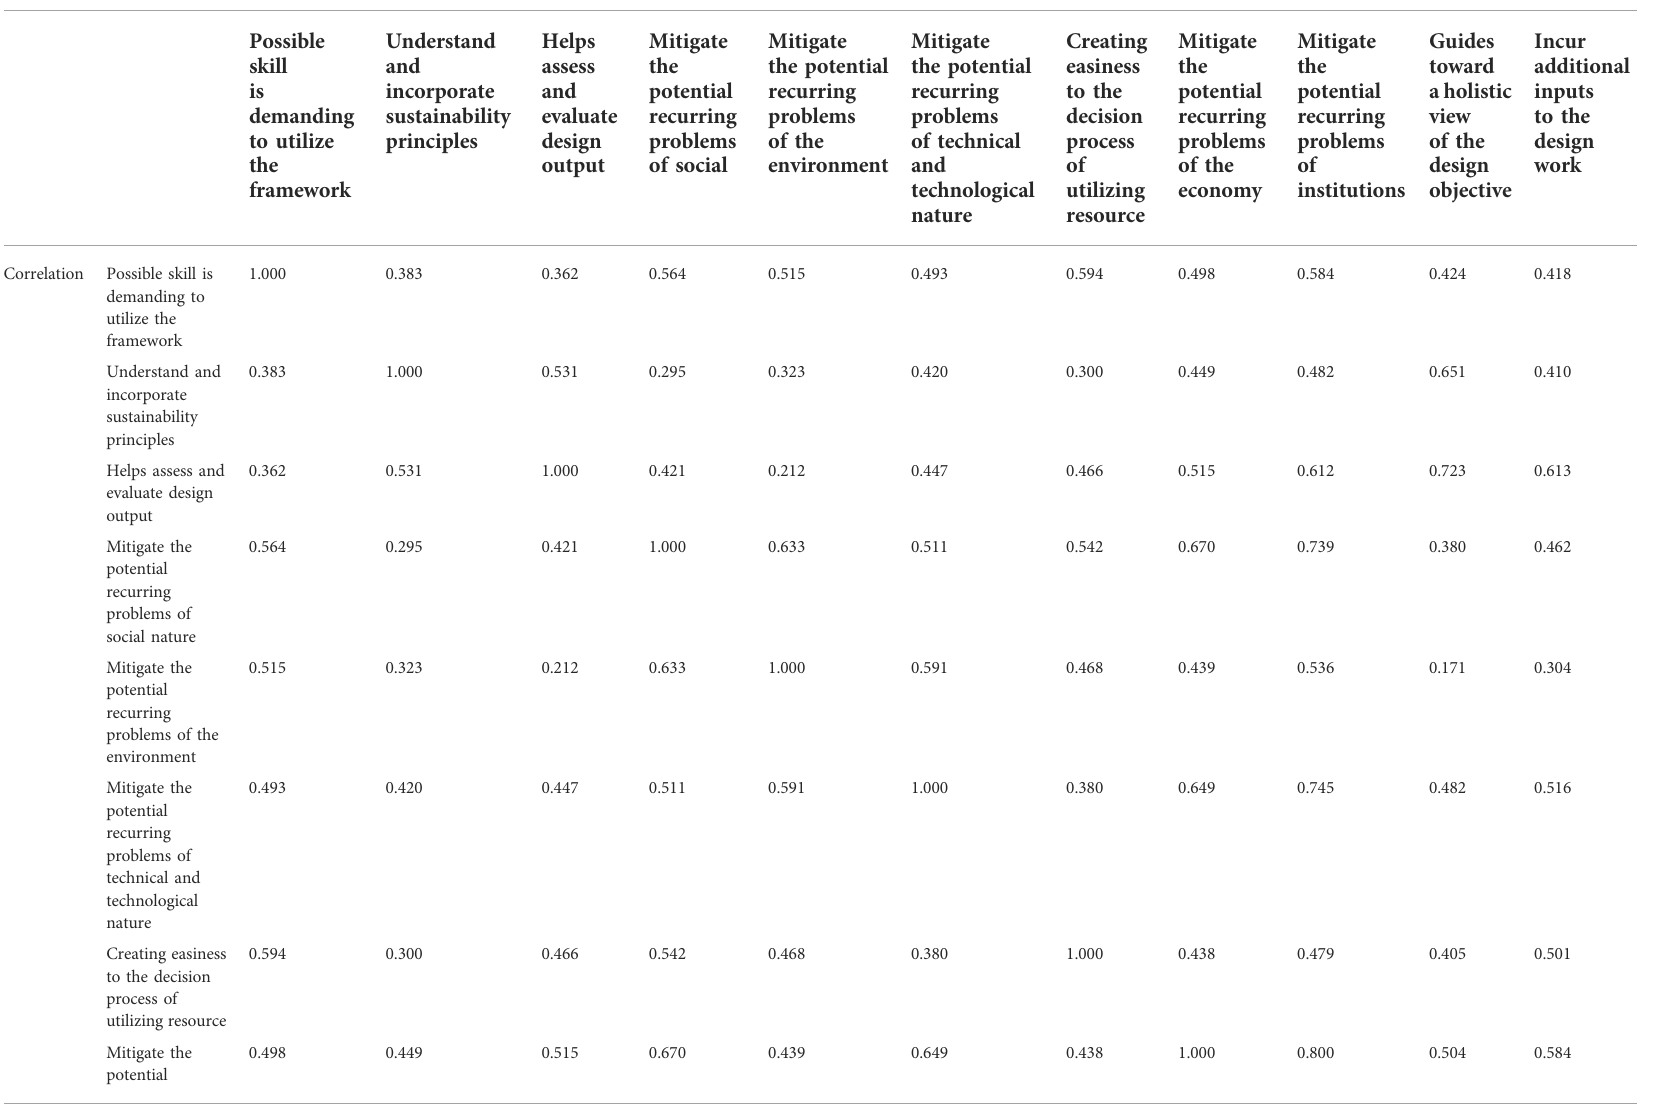
TABLE 5 Correlational matrix among the factors using the Oblimin rotation